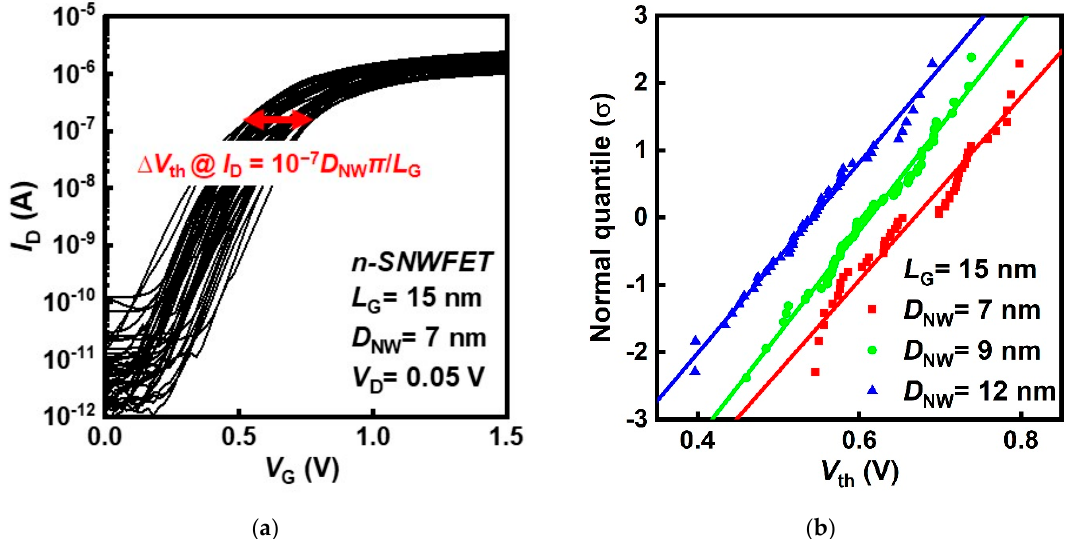
Figure 2. ( a ) V th fluctuation in I D − V G of silicon nanowire field-effect transistors (SNWFETs) with L G = 15 nm and D NW = 7 nm. V th is directly extracted using the constant current method at I D = 10 − 7 · π D NW / L G . ( b ) Quantile plot of V th of the SNWFET with L G = 15 nm. Figure 3 is the Pelgrom plot of σ V th in SNWFETs for each D NW , showing the trend of σ V th as channel area changes. The slope of the Pelgrom plot, defined as the Pelgrom coefficient ( A vt ), represents the effect of random variation [4]. The y-intercept of the Pelgrom plot is also observed, indicating the effect of the process variation and short channel effect [12,24]. Remarkably, the values of A vt and y-intercepts differed for each D NW , and the σ V th is smallest in median D NW of 9 nm. We anticipated that this result implies a trade-off relationship between the various variation sources. Hence, a novel modeling approach is proposed to analyze the contribution of each variation source to σ V th .